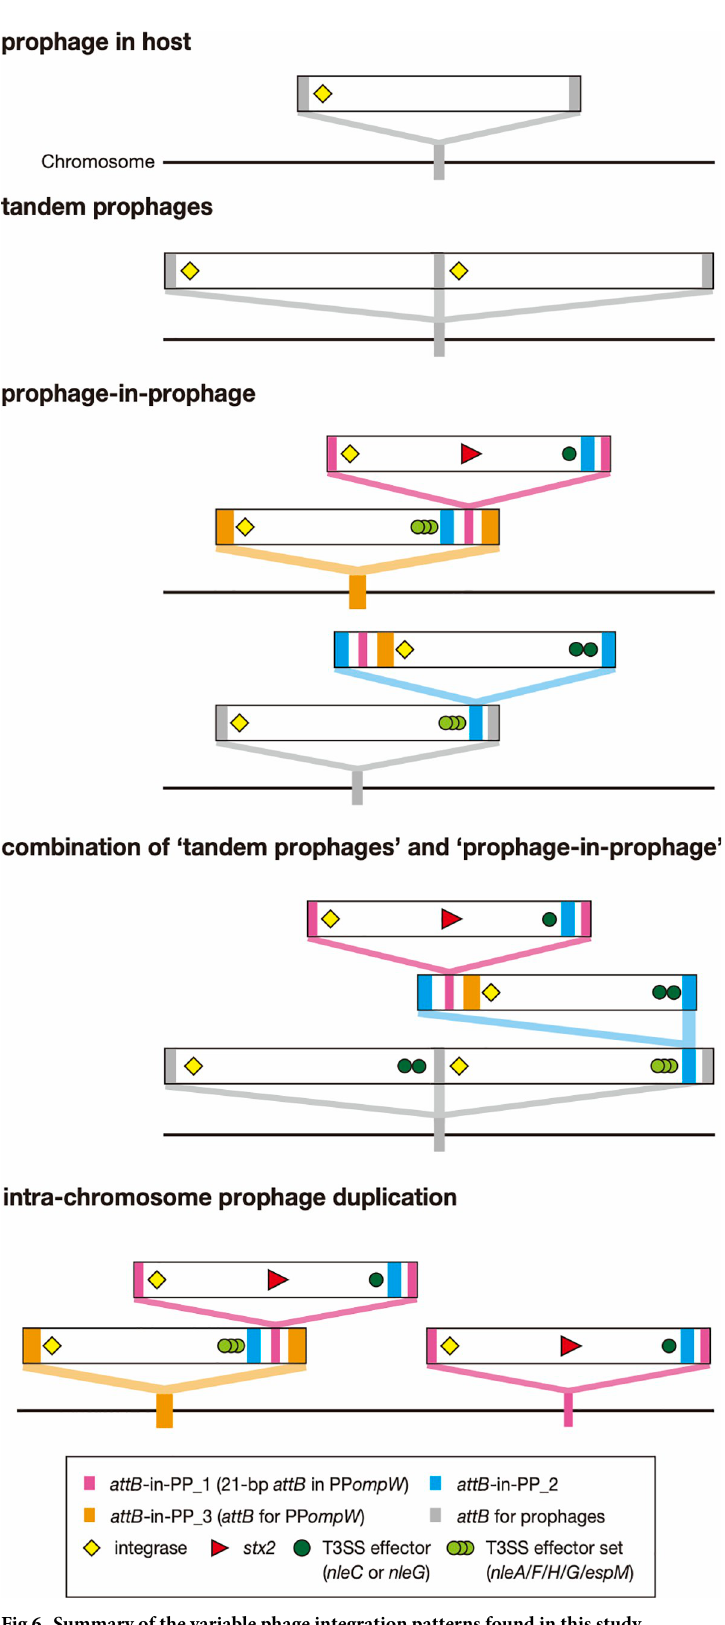
Fig 6. Summary of the variable phage integration patterns found in this study. https://doi.org/10.1371/journal.ppat.1009073.g006 PLOS Pathogens| https://doi.org/10.1371/journal.ppat.1009073 April 29,